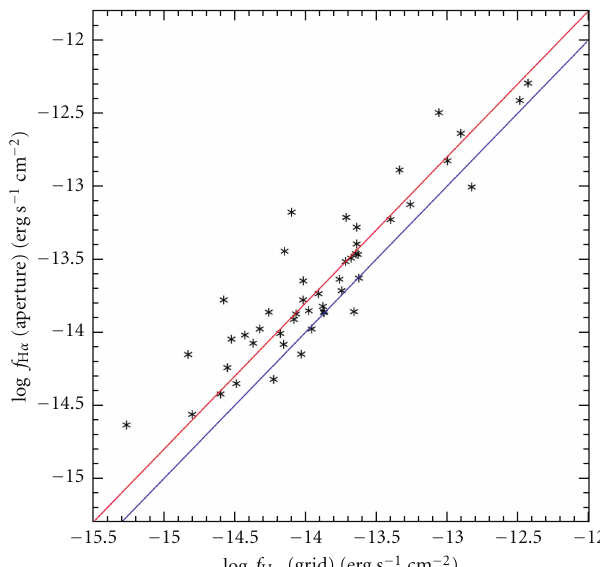
Figure 7: Comparison of the H α flux determined by grid photometry of the HII regions versus aperture photometry of the entire galaxy volume. The red line is a linear fit to the data, and the blue line is the one-to-one correspondence line. The aperture values are, on average, 40% higher than the grid photometry values. This can be attributed to di ff use emission presumably spread throughout the galaxy stellar population